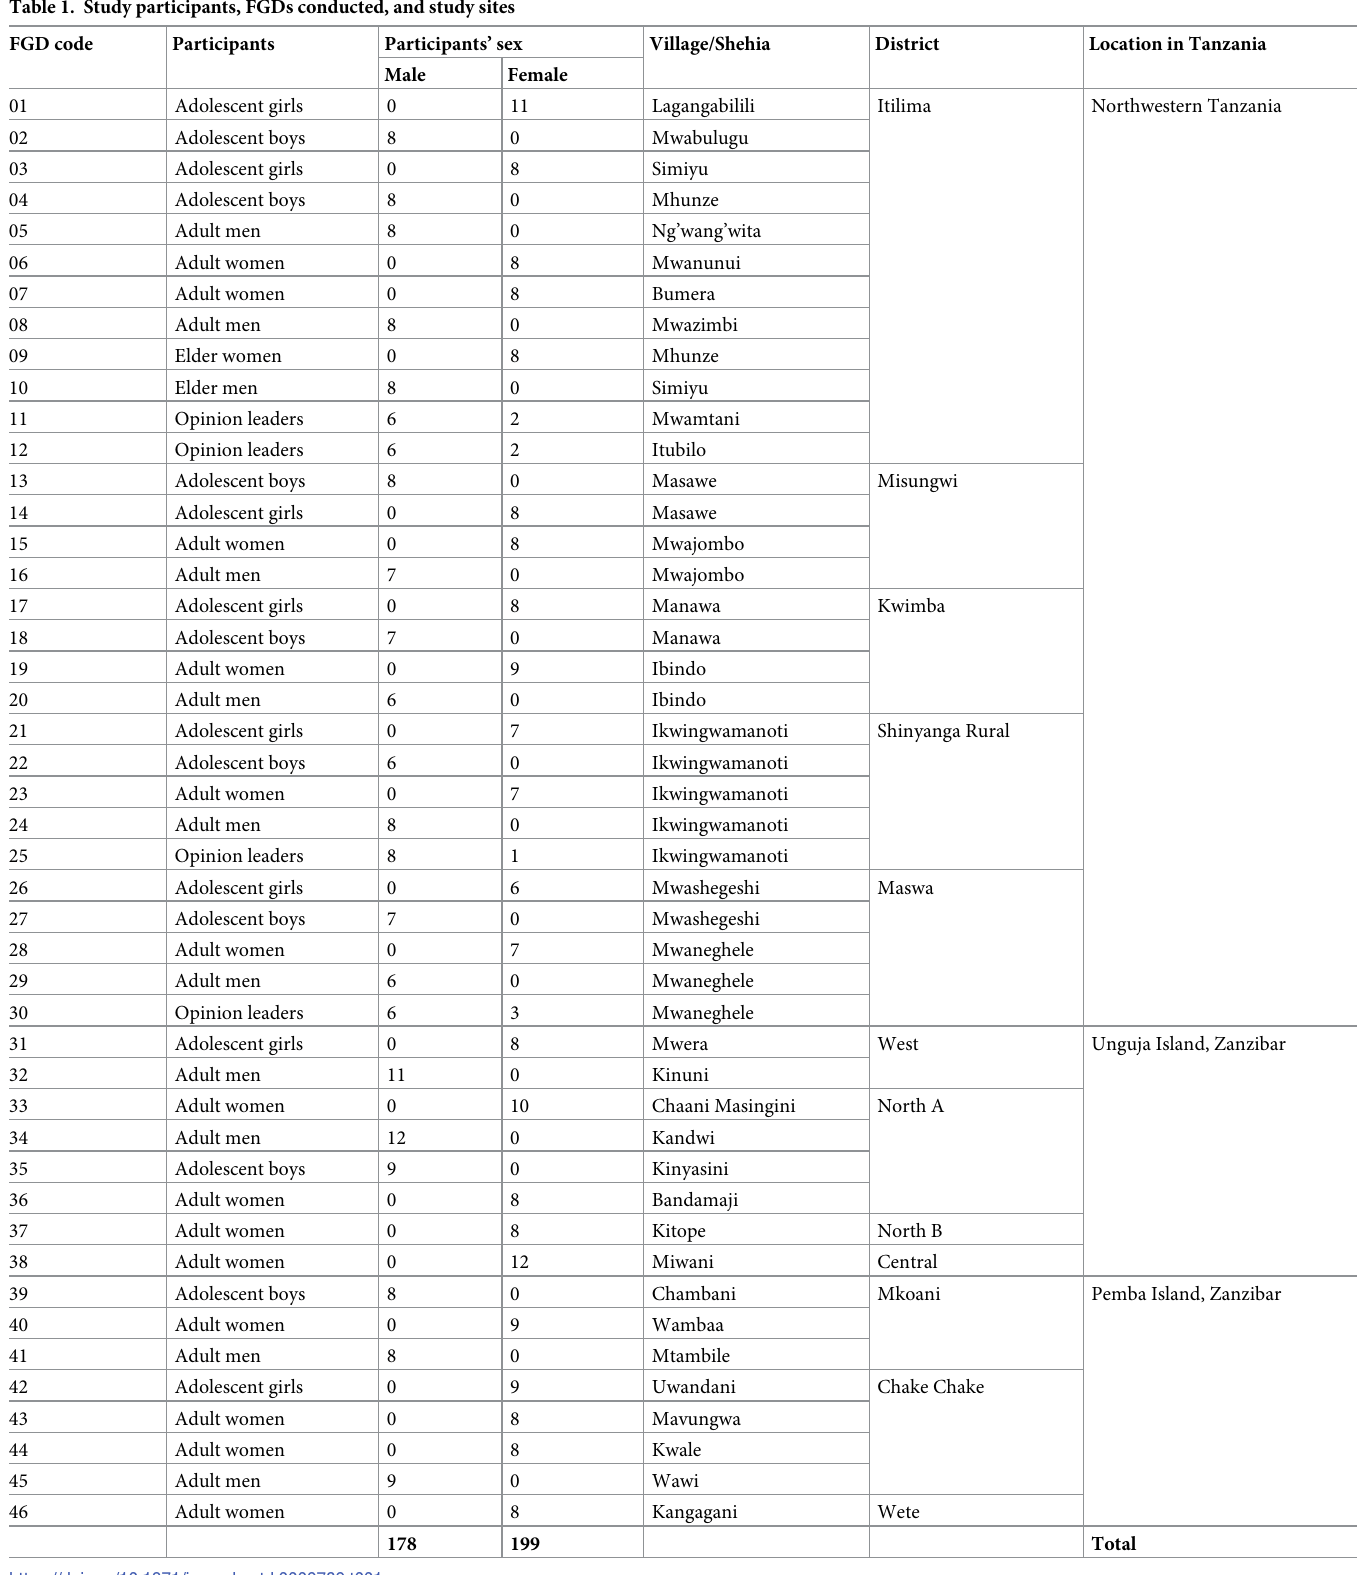
Table 1. Study participants, FGDs conducted, and study sites FGD